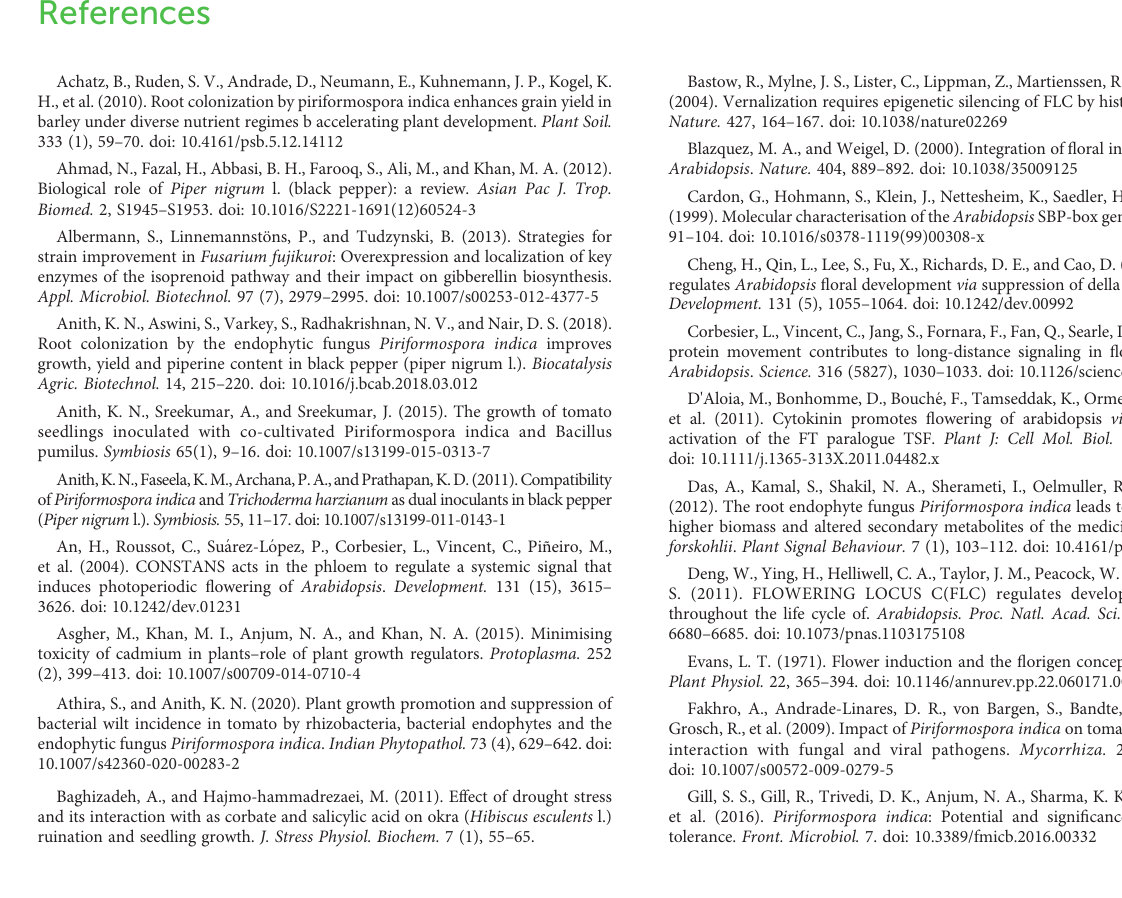
SUPPLEMENTARY FIGURE 2 SEM analysis (FEI- NOVA NANO SEM, Columbia) of gold sputter coated Piriformospora indica spores in native form grown on the cellophane membrane over PDA